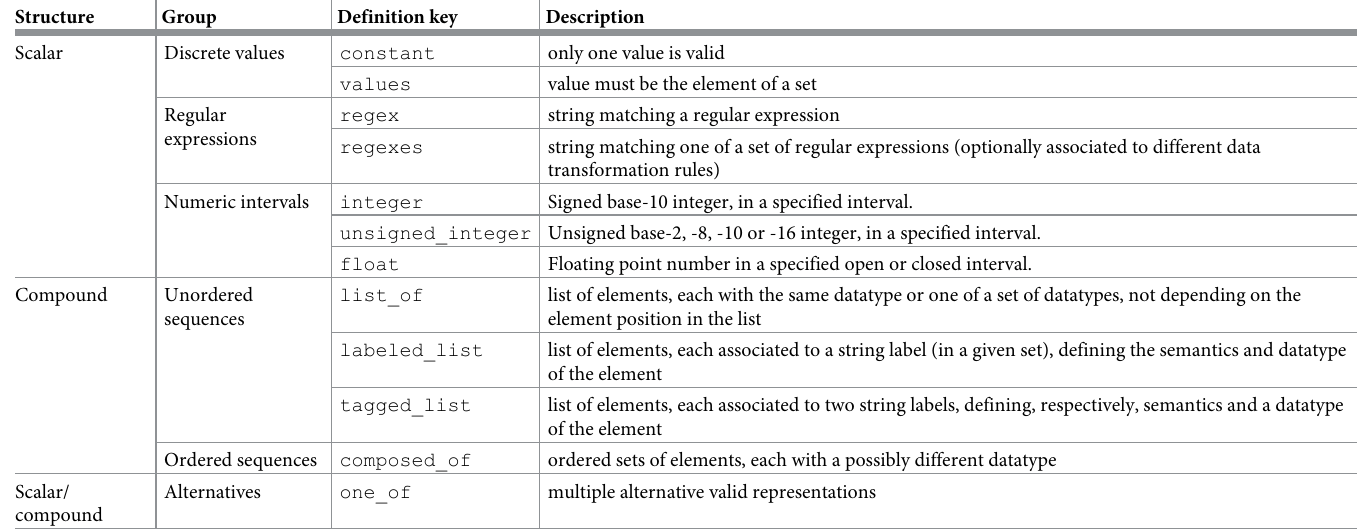
Table 1. Kinds of datatype definitions in the Text Formats Specification Language